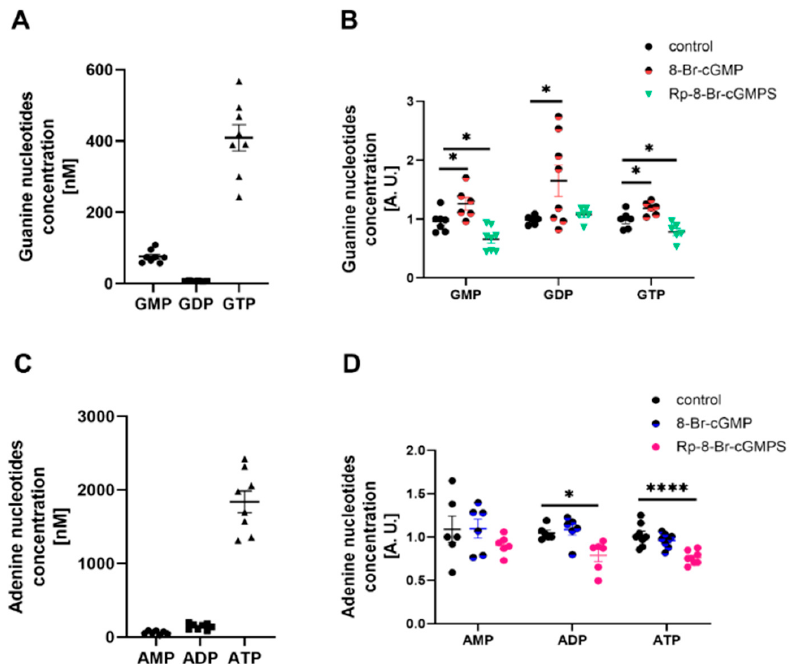
Figure 5. Effect of PKG modulators on the energy state of podocytes. ( A , C ) Guanine ( A ) and adenine ( C ) nucleotide levels in cultured rat podocytes; ( B , D ) Effect of 8-Br-cGMP (PKG activator, 100 µ M, 5 min) and Rp-8-Br-cGMPS (PKG inhibitor, 100 µ M, 20 min) on concentrations of guanine ( B ) and adenine ( D ) nucleotides in cultured podocytes. The data were analyzed using Dunnett’s test and are expressed as the mean ± SEM. n = 6–8. * p < 0.05, **** p < 0.0001, compared with appropriate control.